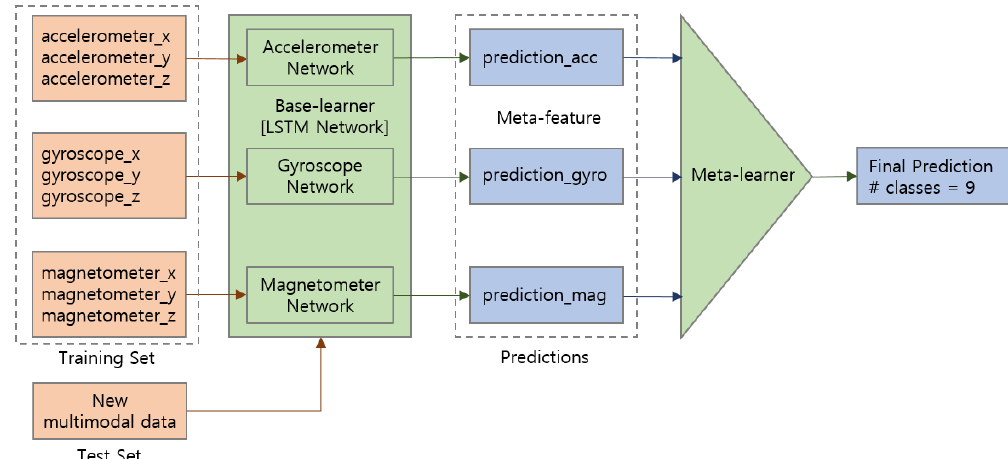
Figure 5. Classifier-level ensemble for multimodal sensor fusion. Prediction results from each sensor modality are used as meta-features for the